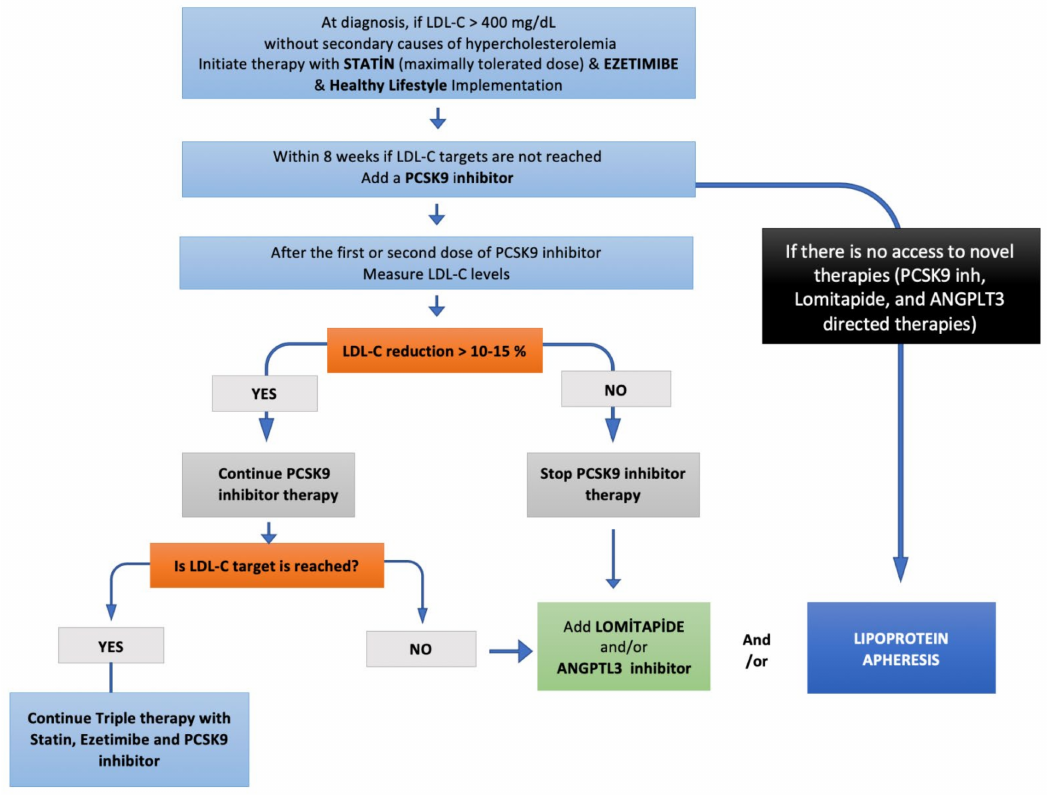
Figure 3. Step-by-step HoFH treatment